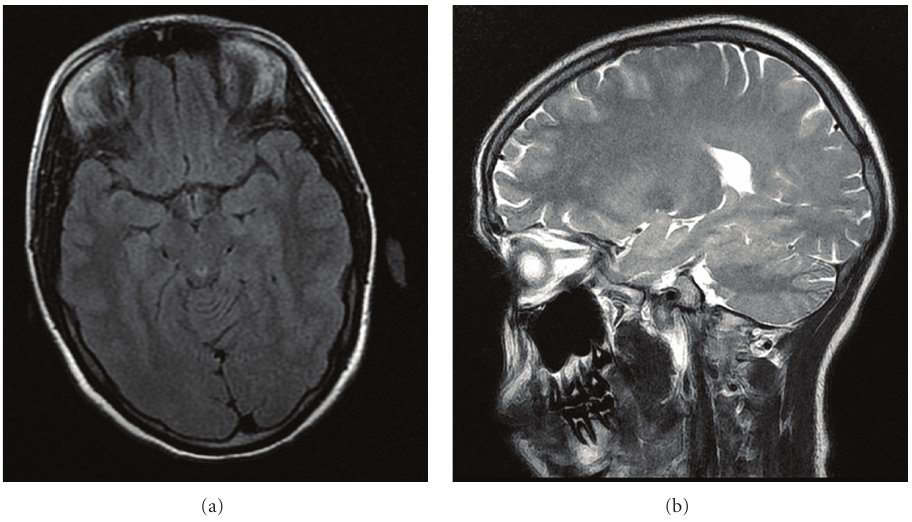
Figure 2: The patient MRI findings in one month